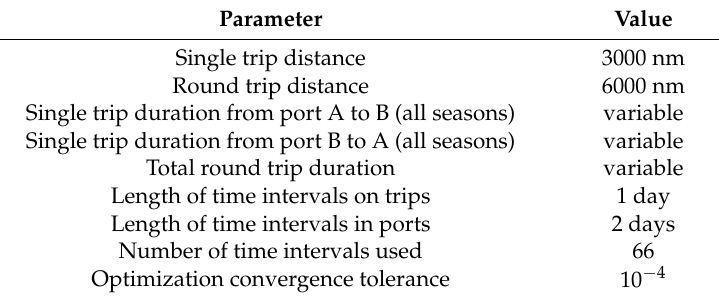
Table 25. Numerical solution parameters.